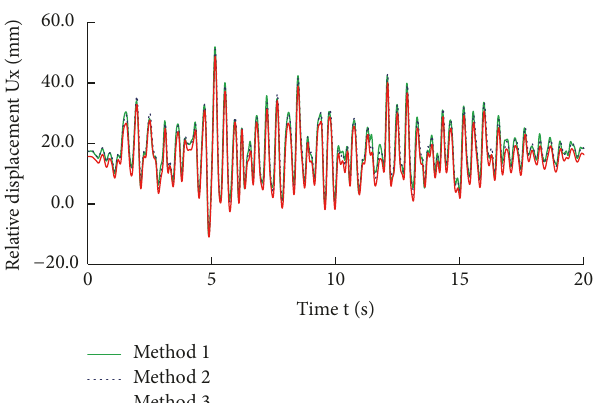
Figure 22: Normalized relative displacement in the x direction at different heights of the dam.